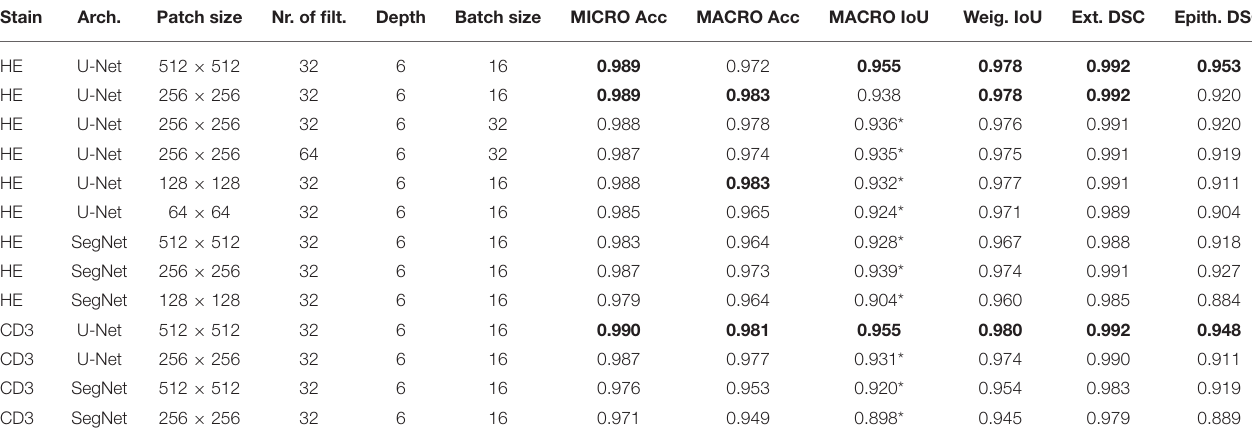
TABLE 1 | Comparative accuracies on the HE stained ( n = 36) and CD3 immunostained ( n = 21) test sets with different hyperparameter settings for U-Net and SegNet. Stain Arch.